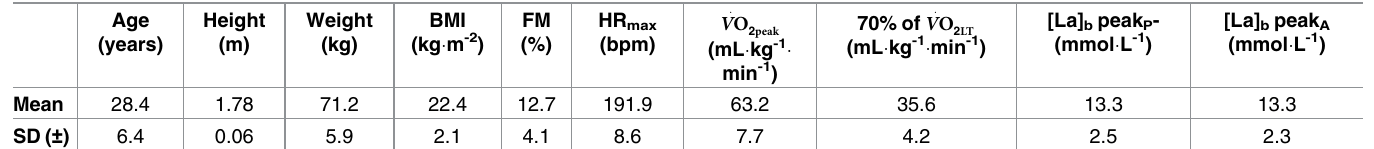
Table 1. Participants’ characteristics and baseline assessments/calculations.